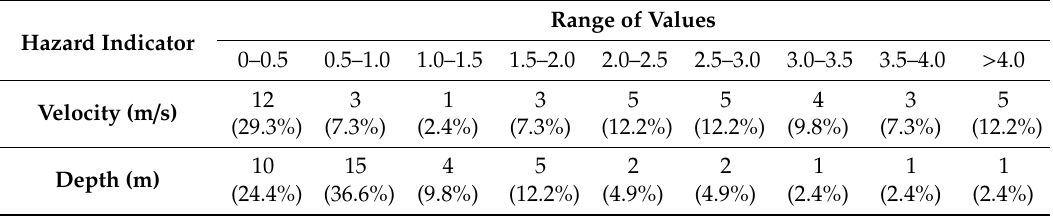
Table 4. Number of a ff ected buildings distributed by ranges of flood velocity and water depth. Hazard